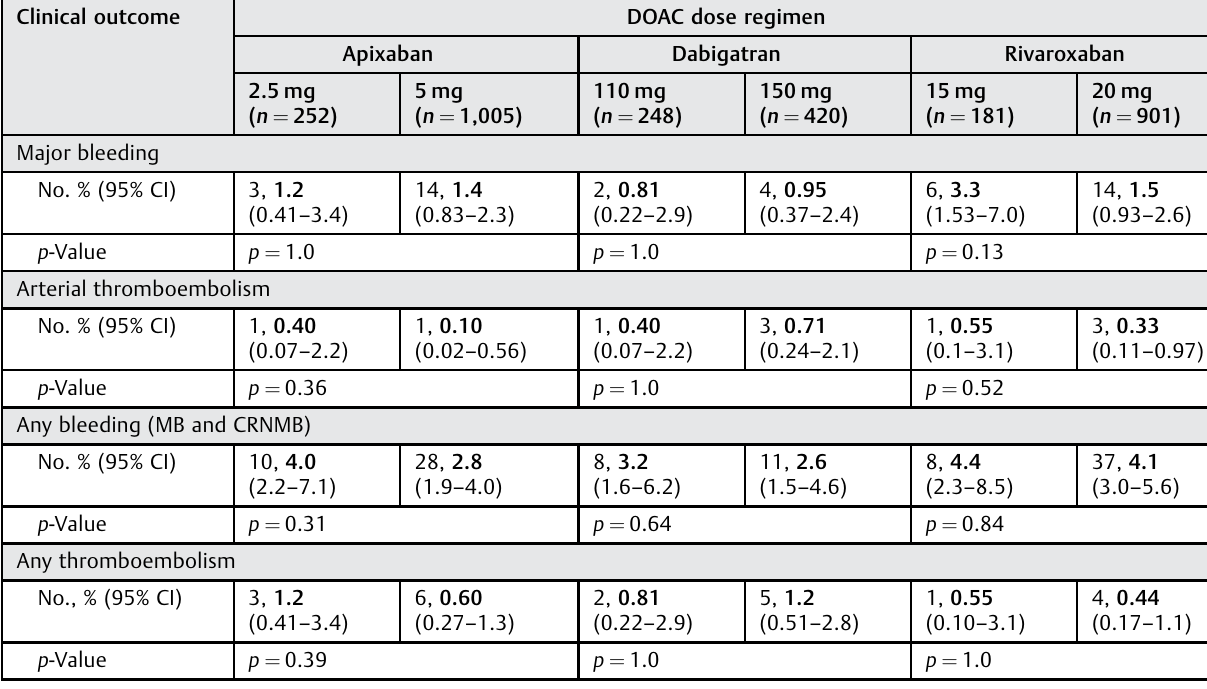
Table 3 Effect of DOAC dose regimen on clinical outcomes Clinical